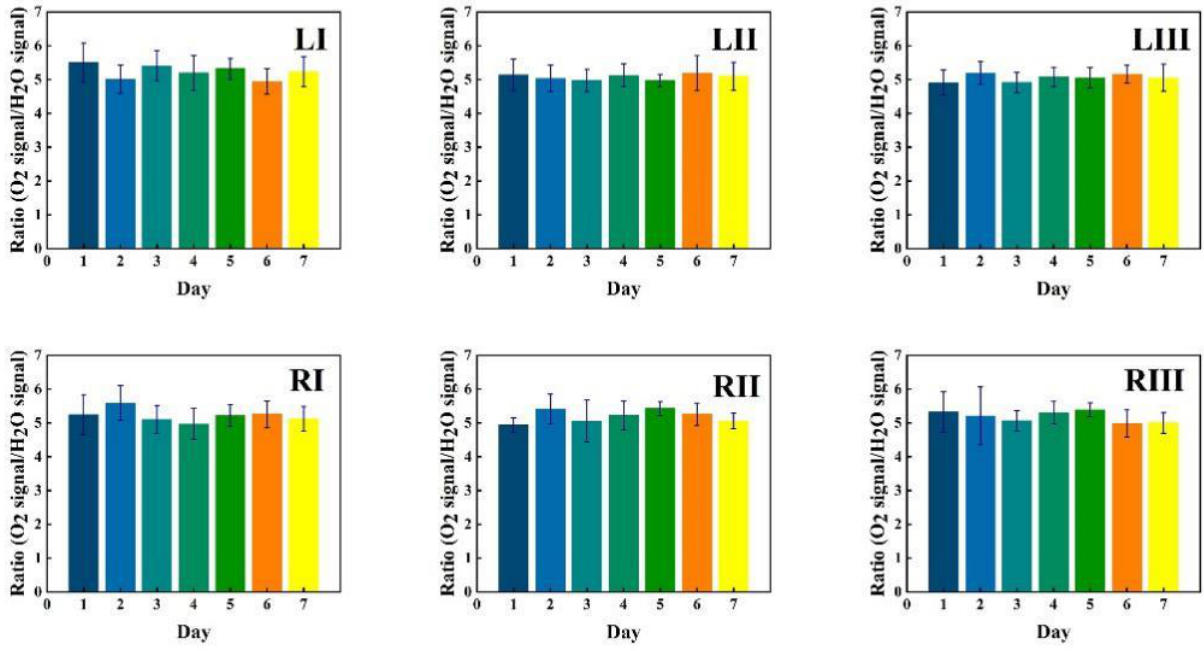
Figure 7. The ratio of measured oxygen and water vapor signals at different locations for volunteer 1 during one week, together with the standard deviation.